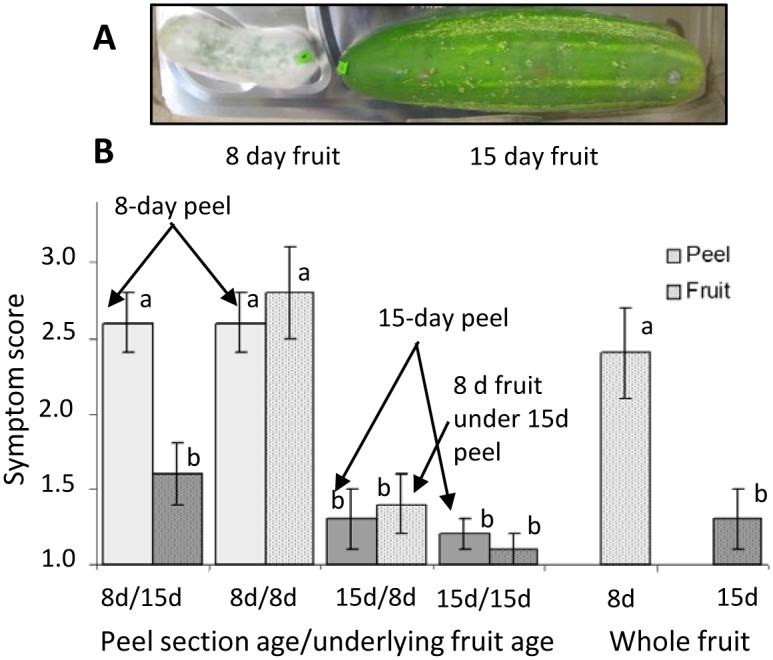

Phytophthora capsici disease development on cucumber fruit and peels.(A) Pathogen growth on whole, unwounded cucumber fruit. Fruit were harvested at 8 or 15 days post pollination (dpp) and inoculated with zoospore suspensions of P. capsisi. The photograph was taken at 5 days post-inoculation. The 8 dpp fruit is covered with mycelial growth. (B) Disease development on peel sections and underlying fruit, or directly inoculated whole fruit as described in methods. x/y indicates age of overlying peel section/age of underlying intact fruit. Symptom score: 1 = no symptoms or localized necrosis; 2 = water soaking; 3 = sporulation. Each value is the mean of at least 9 fruit ±se. Bars marked with different letters indicate significant different, ANOVA, LSD, P<0.05.